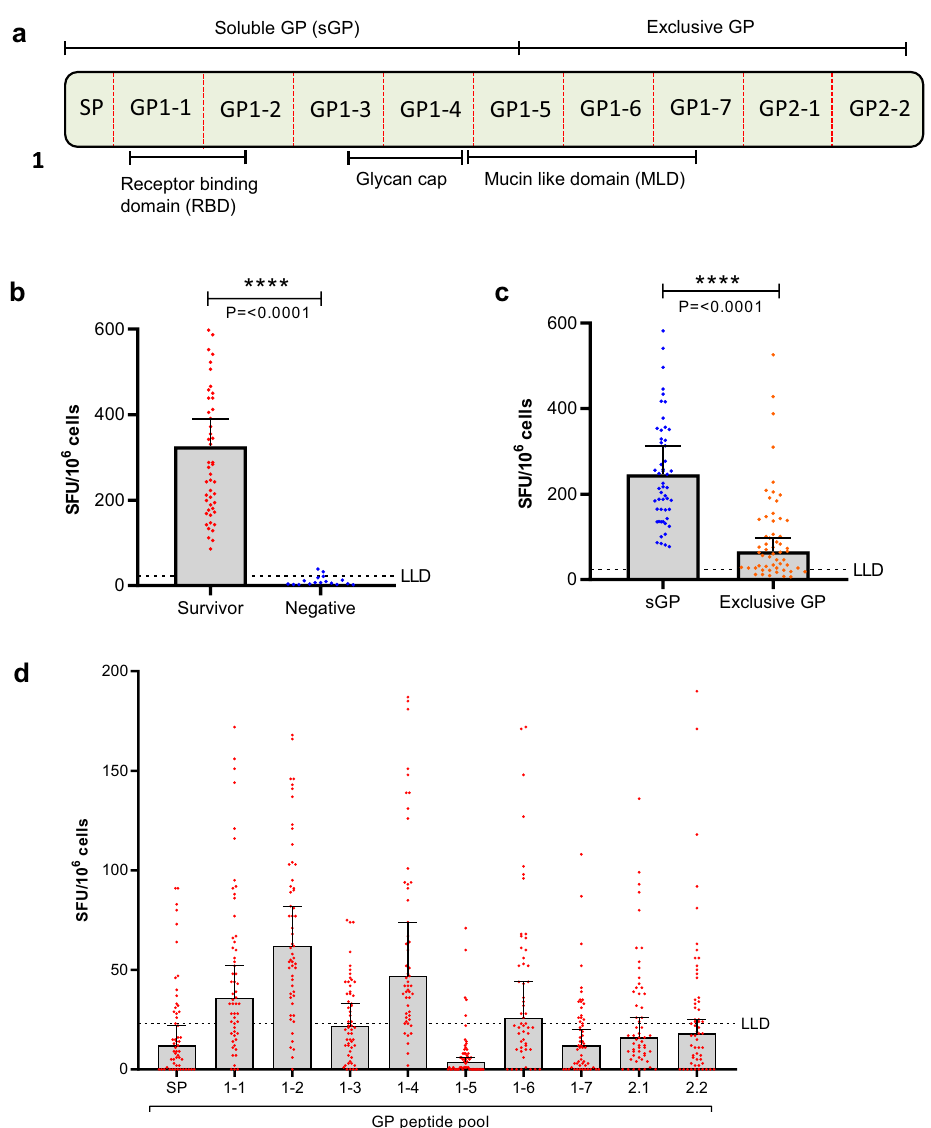
Fig. 1 Cellular immune response, using fresh PBMC, to EBOV GP (Mayinga) peptide library as measured by IFN γ ELISpot. a Schematic representation of the EBOV glycoprotein highlighting notable regions and peptide pools used in ELISpot analysis. SP = Signal peptide. b The summed ELISpot response to all GP peptides in the library amongst 57 EVD survivor and 18 non-exposed, negative, PBMC samples. c ELISpot response amongst 57 EVD survivors to either sGP or exclusive GP portions of the glycoprotein. d The ELISpot response amongst 57 EVD survivors to each peptide pool. For graphs b – d bars represent the median values with the upper 95% con fi dence interval. Two-tailed Mann – Whitney U test used to look for signi fi cance in ( b ) ( p = <0.0001) and two-tailed Wilcoxon test in ( c ) ( p = <0.0001). Dashed black line is the lower limit of detection (LLD) represents the in house cut off value (23 SFU), this is the mean of all negative results in ( b ) plus 3 standard deviations (SD) and discriminates between a positive and negative